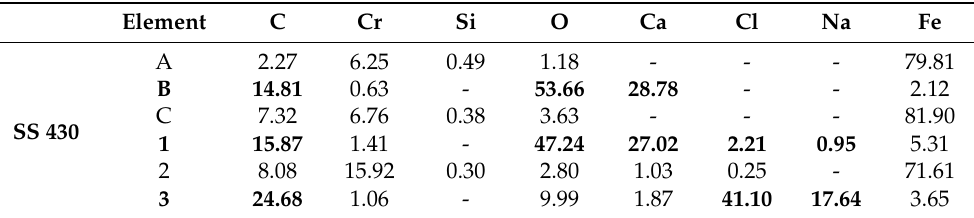
Figure 4. SEM images of SS 430 steel exposed to a cement extract solution +5 g L − 1 : for 7 days ( a ) ×500 and ( b ) ×1000; for 30 days ( c ) ×1000, ( d ) ×1000 and ( e ) ×3000. Table 6. EDS analysis (wt.%) of SS 430 carbon steel surface after exposure to the cement extract solution (+5 g L − 1 NaCl) for 168 h and 720 h (Figure 4).